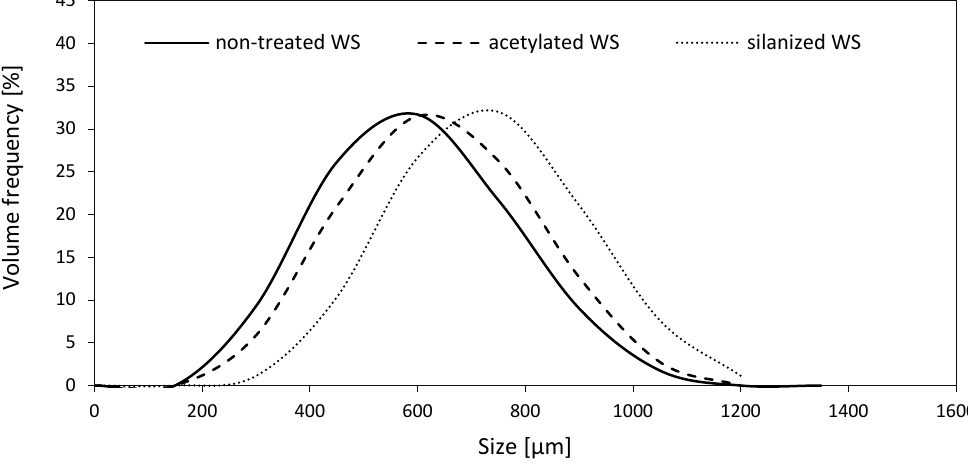
Figure 4. The results of particle size distribution.